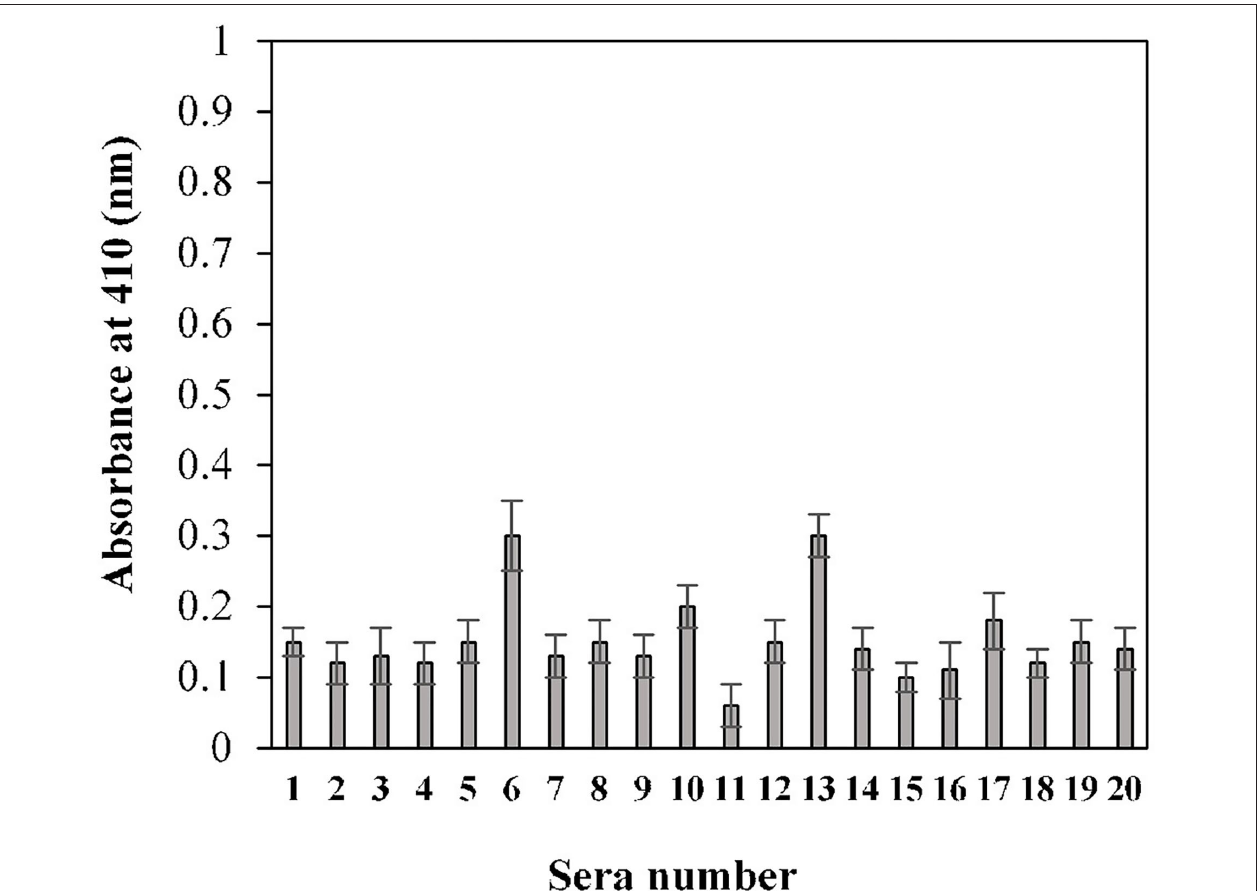
FIGURE 3 | Estimation of cut-off value for indirect binding ELISA. Pre-pandemic serum samples ( n = 20) were used in the ELISA (1:100 dilution) assay against the S1-RBD antigen (2 µ g/ml). Each sample was run in triplicate.